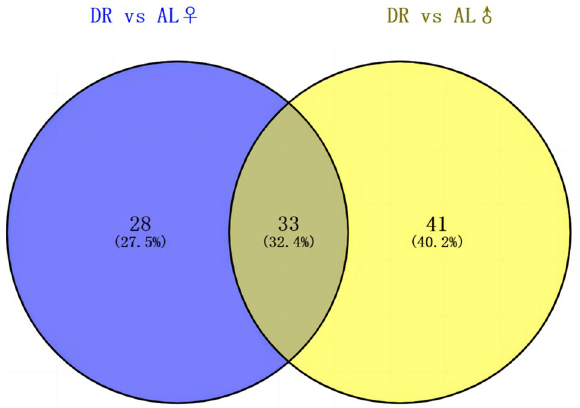
Figure 6. Venn diagram of differential metabolites in the male and female groups. AL, ad libitum feeding; DR, dietary